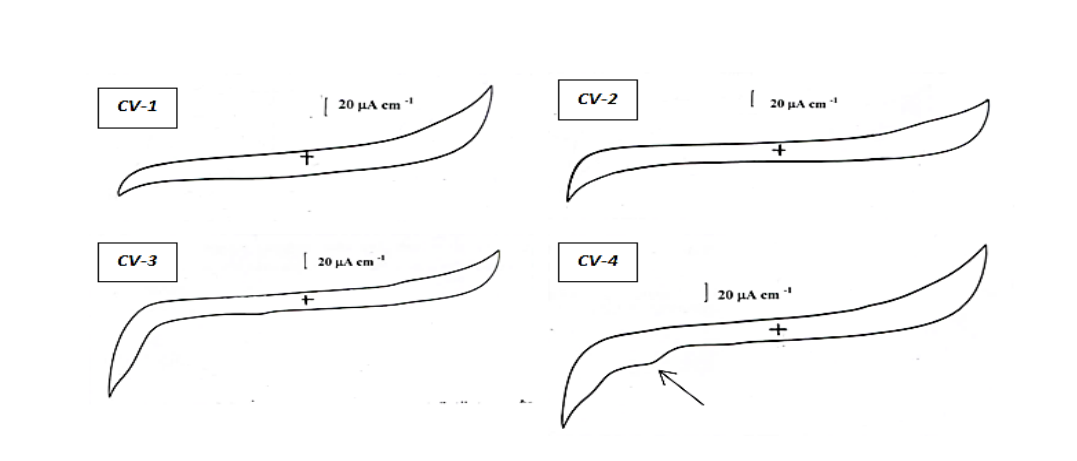
Figure 4: UV-Visible spectra of 10 -4 mol L -1 thiram (dashed line), 10 -4 mol L -1 K K CrO (dotted line). 2 4